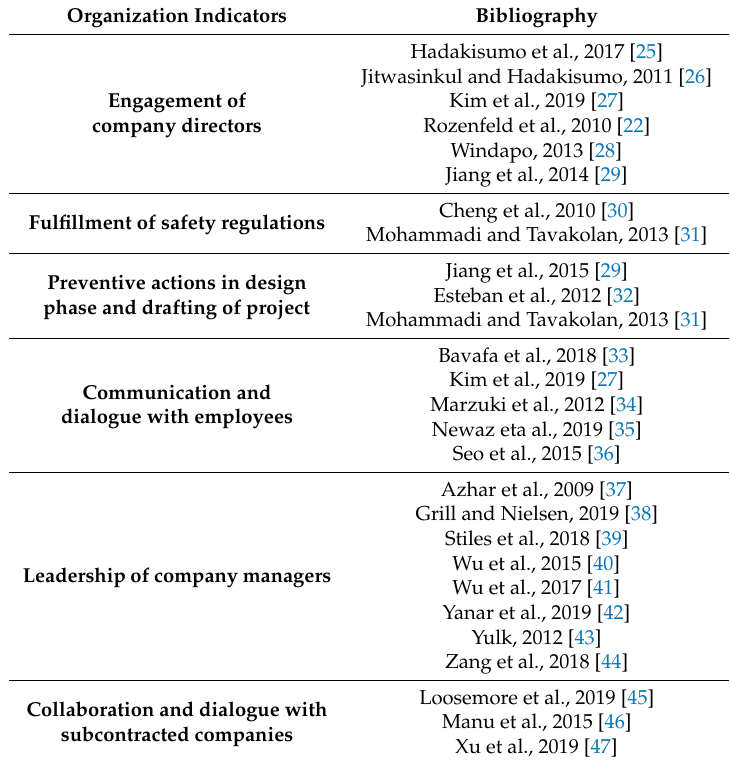
Table 1. Bibliographical references concerning research into corporate leadership and the integration of risk prevention in company system.